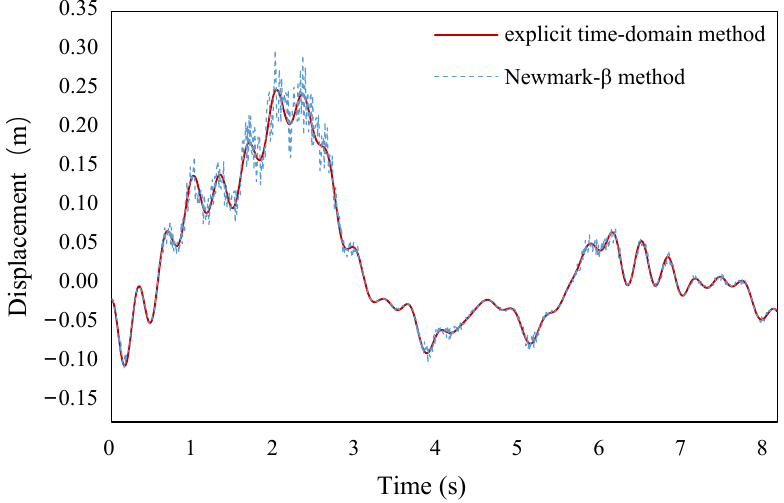
Figure 9. Displacement time-history diagram at the top section of P 2.